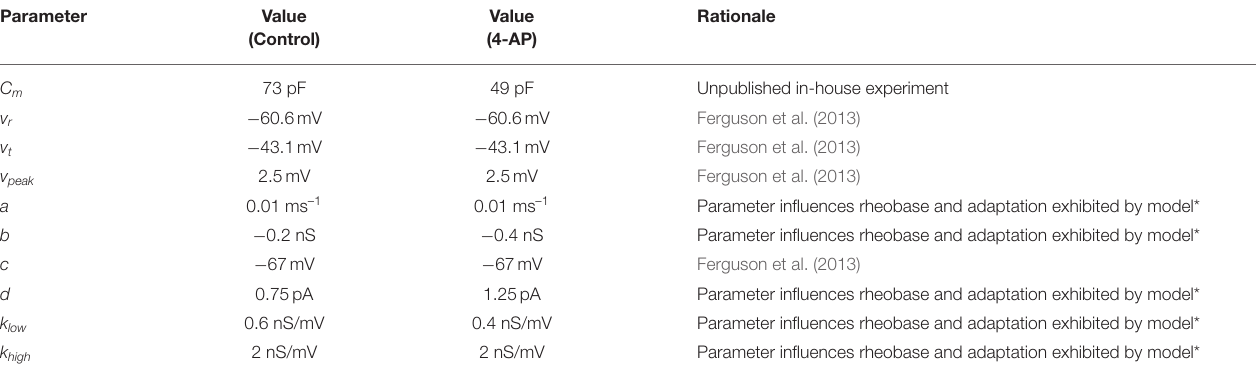
TABLE 1 | Parameters used in neuron models.